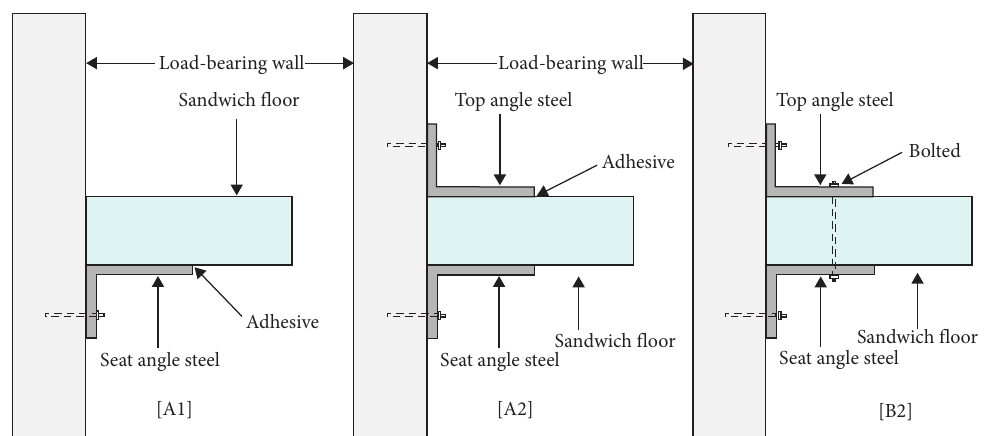
Figure 2: Proposed connection systems (A: adhesively bonded, B: bolted, 1: single bottom steel angle, and 2: top and bottom steel